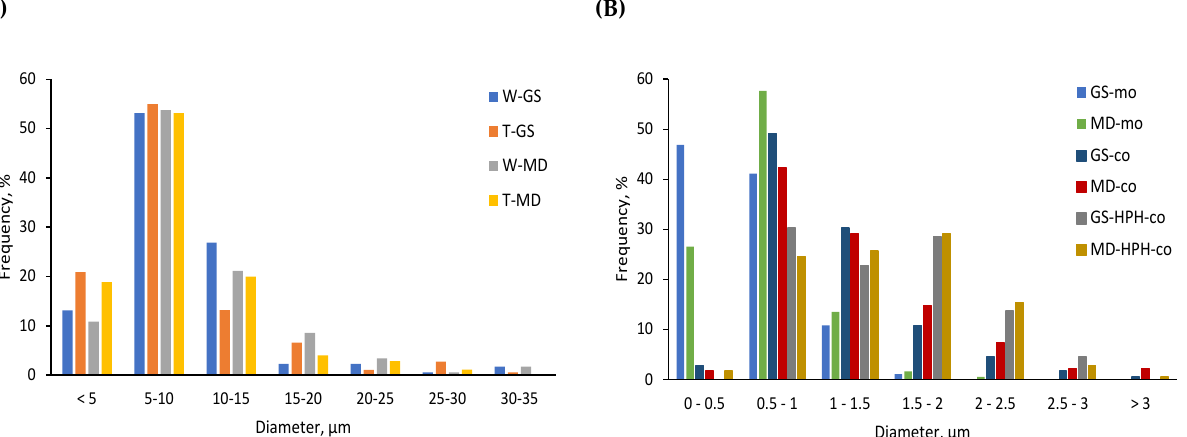
Figure 3. Particle size distribution of the capsules produced by spray-drying (A) and electrospraying (monoaxial and coaxial) (B) .